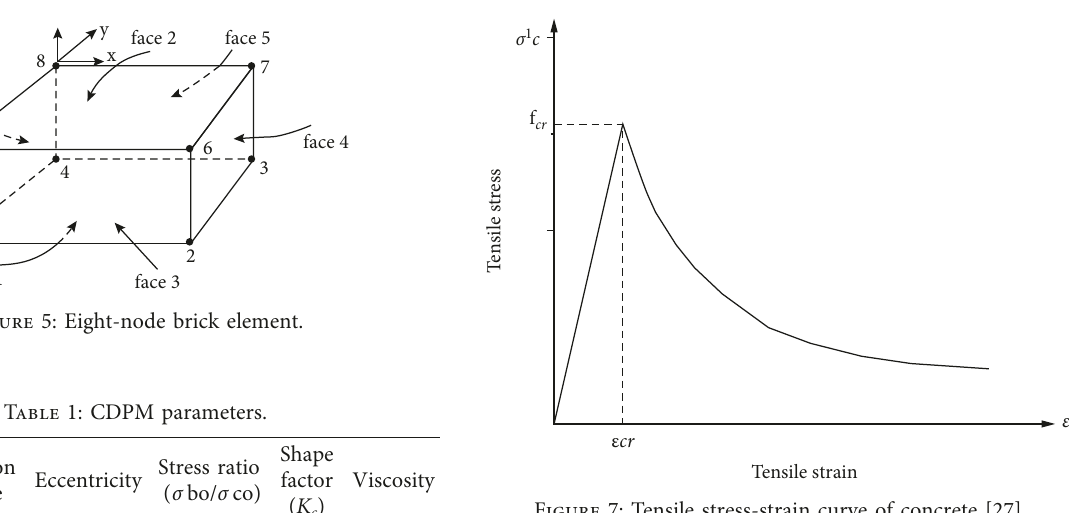
Figure 7: Tensile stress-strain curve of concrete